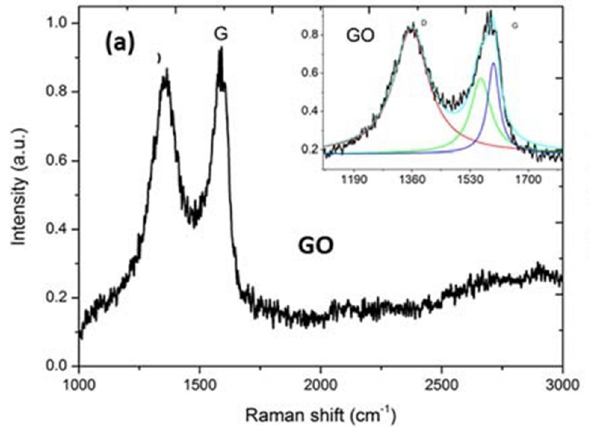
Figure A6. Raman spectrum of GO used in the preparation of the alginate beads.